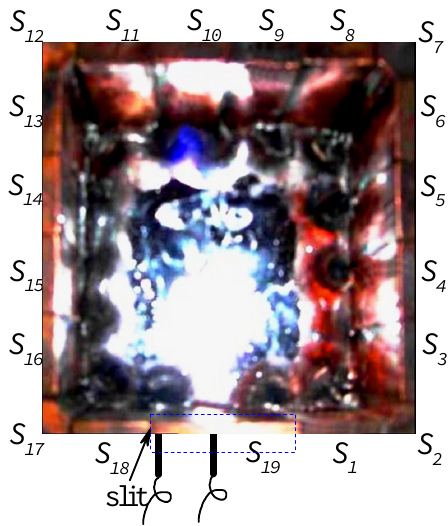
Figure 8. The deformation of the molten